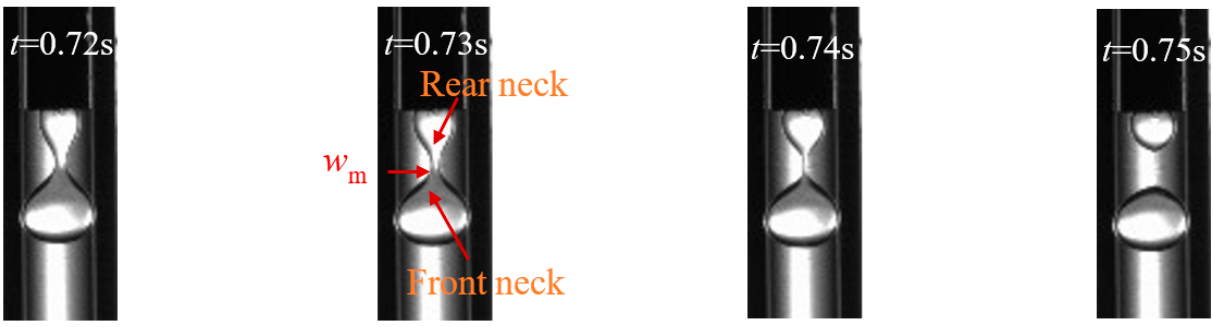
Figure 10. The NaAlg micro-droplet evolution in the pinch-off stage ( n 2 = 0.162, Q d = 2 mL/h, Q c = 40 mL/h).